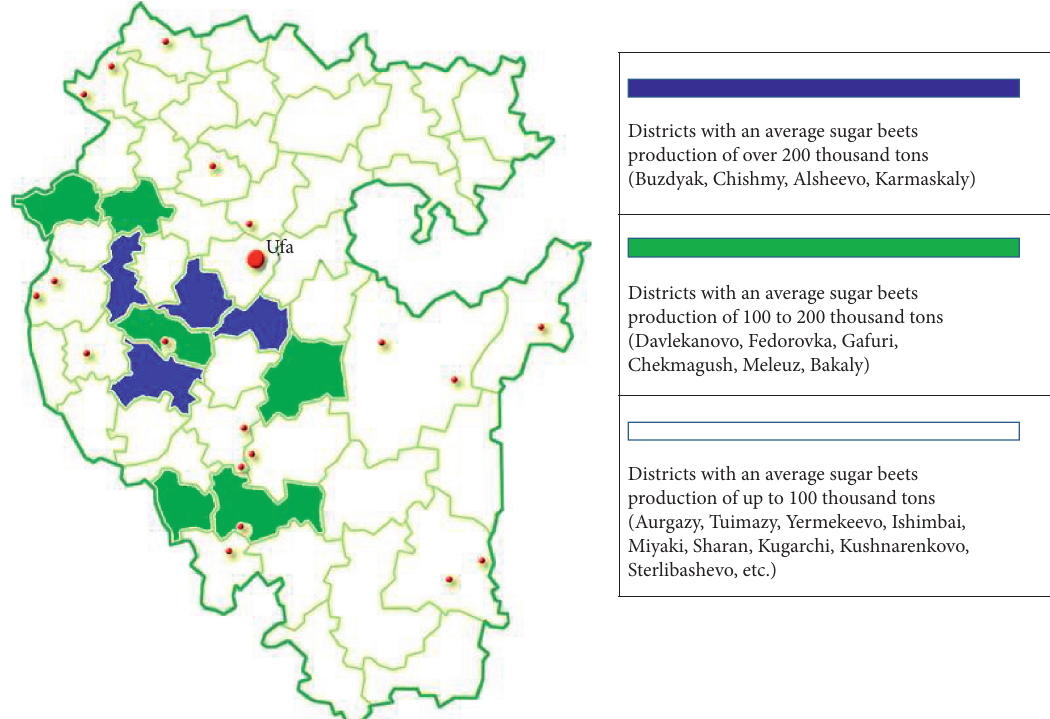
Figure 3: Territorial model of priority of participation in implementation strategic directions of the municipal regions of the republic in the direction of development of sugar beet